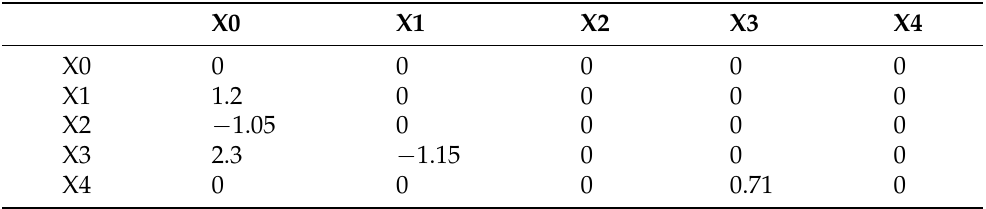
Table 7. First lag matrix for LLC synthetic data set generation from Equation (5): row X m contains the linear combination coefficients of the first lag values ( x component of vector x ( t )